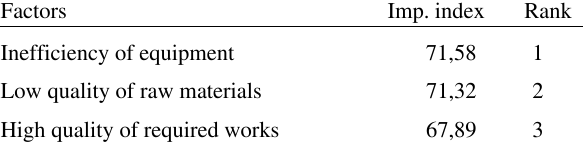
Table 9. Ranking factors in the quality group Factors Imp. index